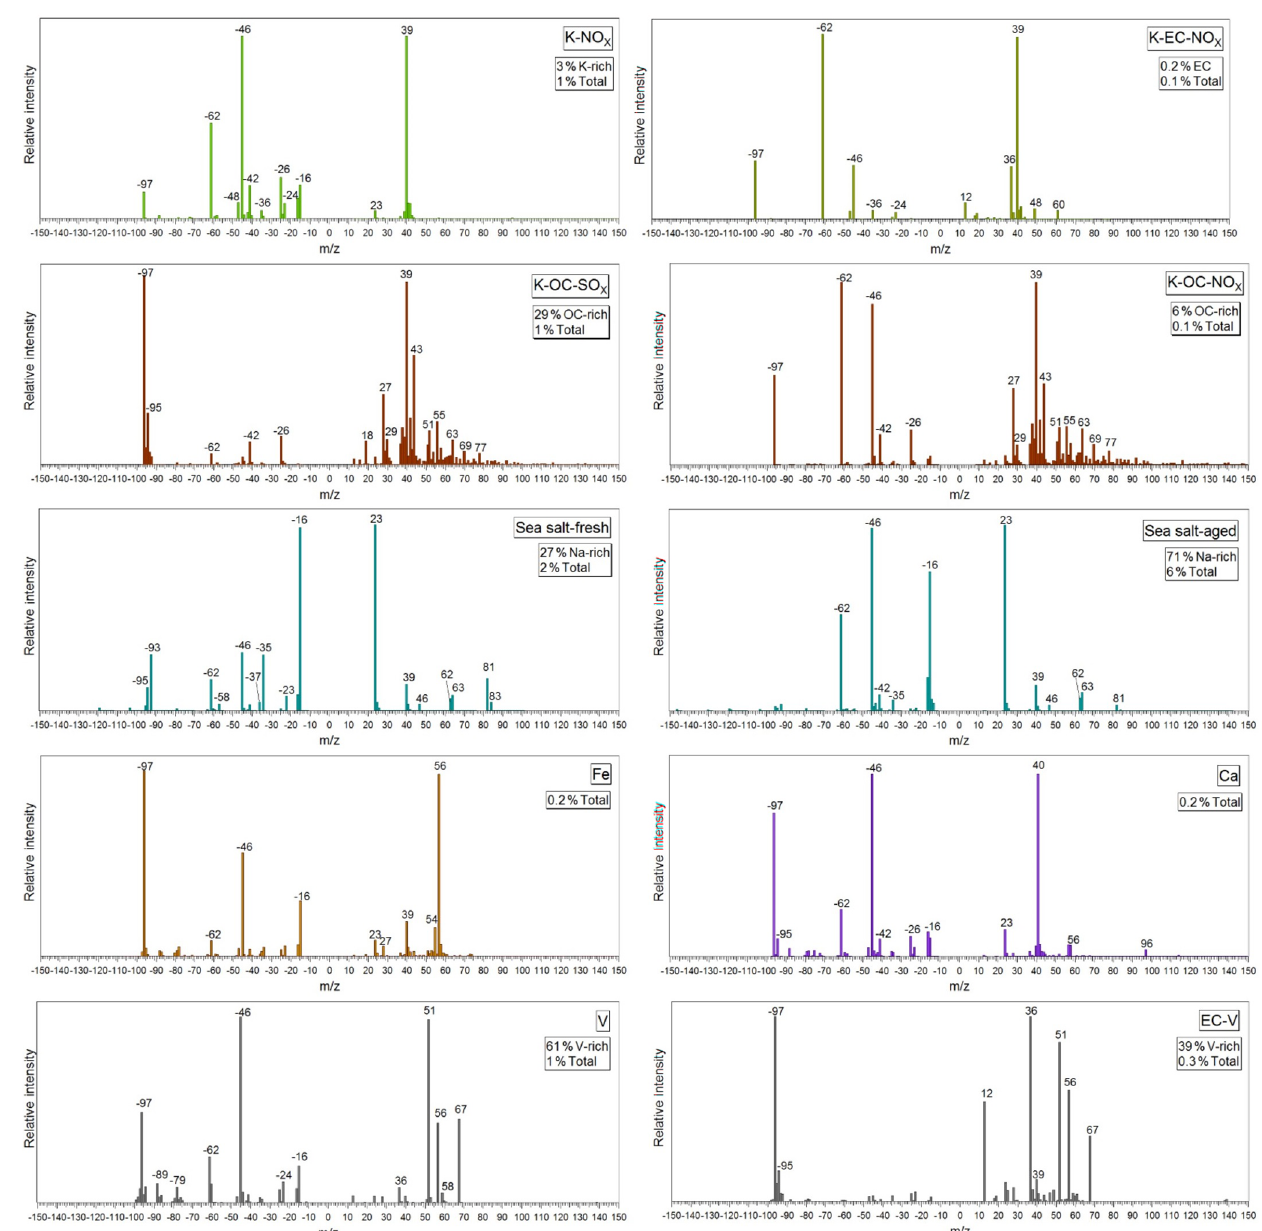
Figure 8. Average mass spectra for ATOFMS particle classes from local biomass burning, marine, dust and shipping sources during ADRIMED and